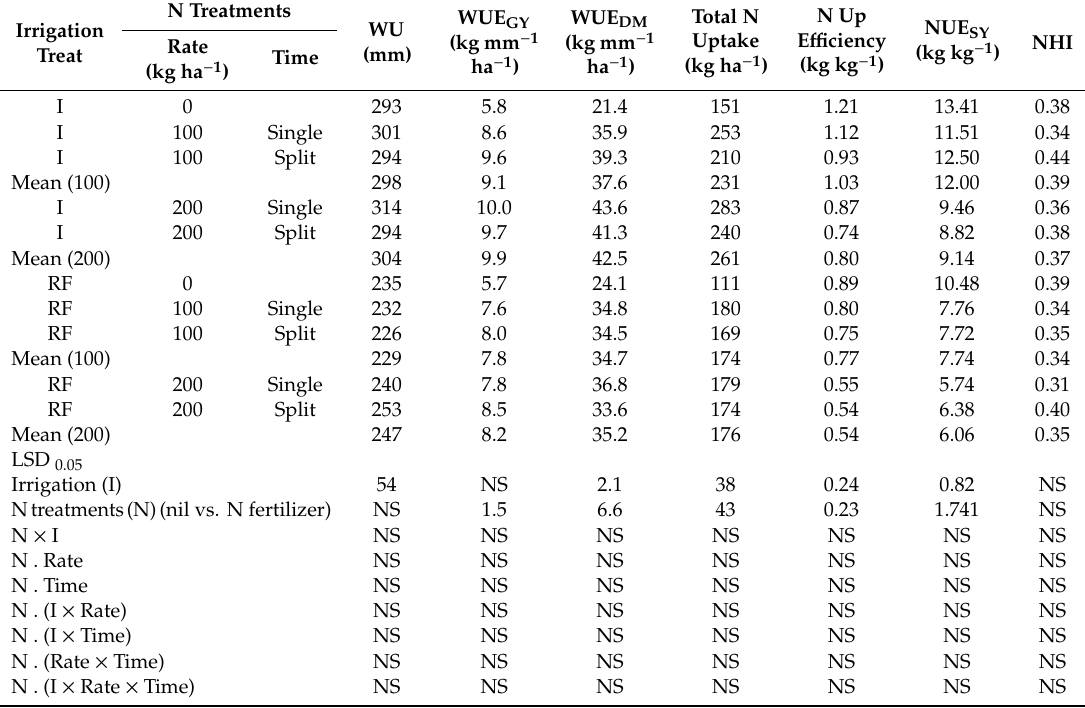
Table 6. E ff ect of di ff erent N applications on water use, water-use e ffi ciency, N uptake e ffi ciency, N-use e ffi ciency for seed yield and nitrogen harvest index (NHI) of canola under irrigated and rainfed conditions at Roseworthy